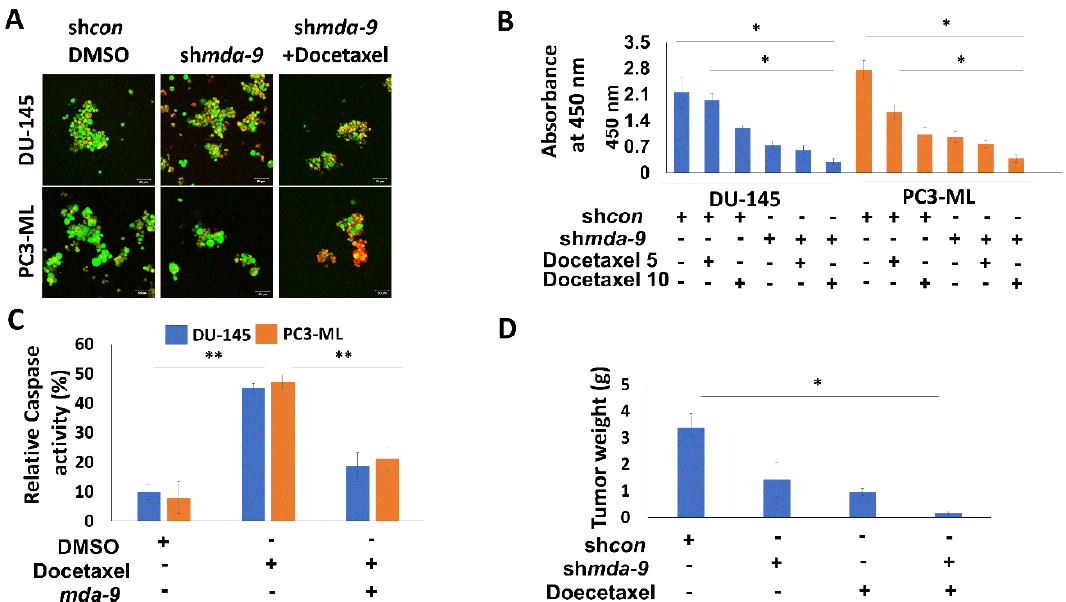
Figure 3. mda-9 regulates chemoresistance in PCSCs. ( A ) E ff ect of mda-9 kd on PCSC sensitivity to Docetaxel assessed by Live / Dead assay: live cells are green, dead cells are red. ( B ) E ff ect of mda-9 kd on PCSC sensitivity to Docetaxel (5 and 10 nM), assessed by MTT assay. ( C ) E ff ect of mda-9 overexpression on PCSC sensitivity to Docetaxel assessed by caspase activity. ( D ) E ff ect of intra-tumoral mda-9 kd on Docetaxel sensitivity measured by tumor weight ( n = 10). The bars represent SEM. * p < 0.05, ** p < 0.01, using the Student’s t -test and ANOVA.